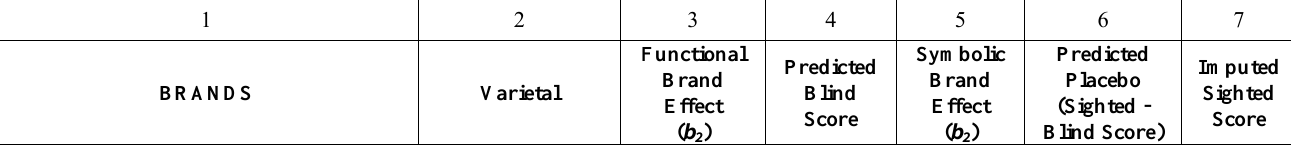
Table 13: The 35 brands that qualify simultaneously with functional and symbolic/placebo effects. These brands are ranked by (reverse) order of the b functional brand effect (column 3) used to derive the predicted blind score in column 4. 2 The figure in column four is added to the predicted placebo (sighted minus blind score) in column 6 to impute the sighted score in column 7. (All figures featured are derived from the models featured in Tables 9 and 10) This set of brands decomposes into the zones of Symbolic Value (n=9) and Functional Value (n=26) as illustrated in Figure 2. Positive b effects are shaded in light grey, negative effects in